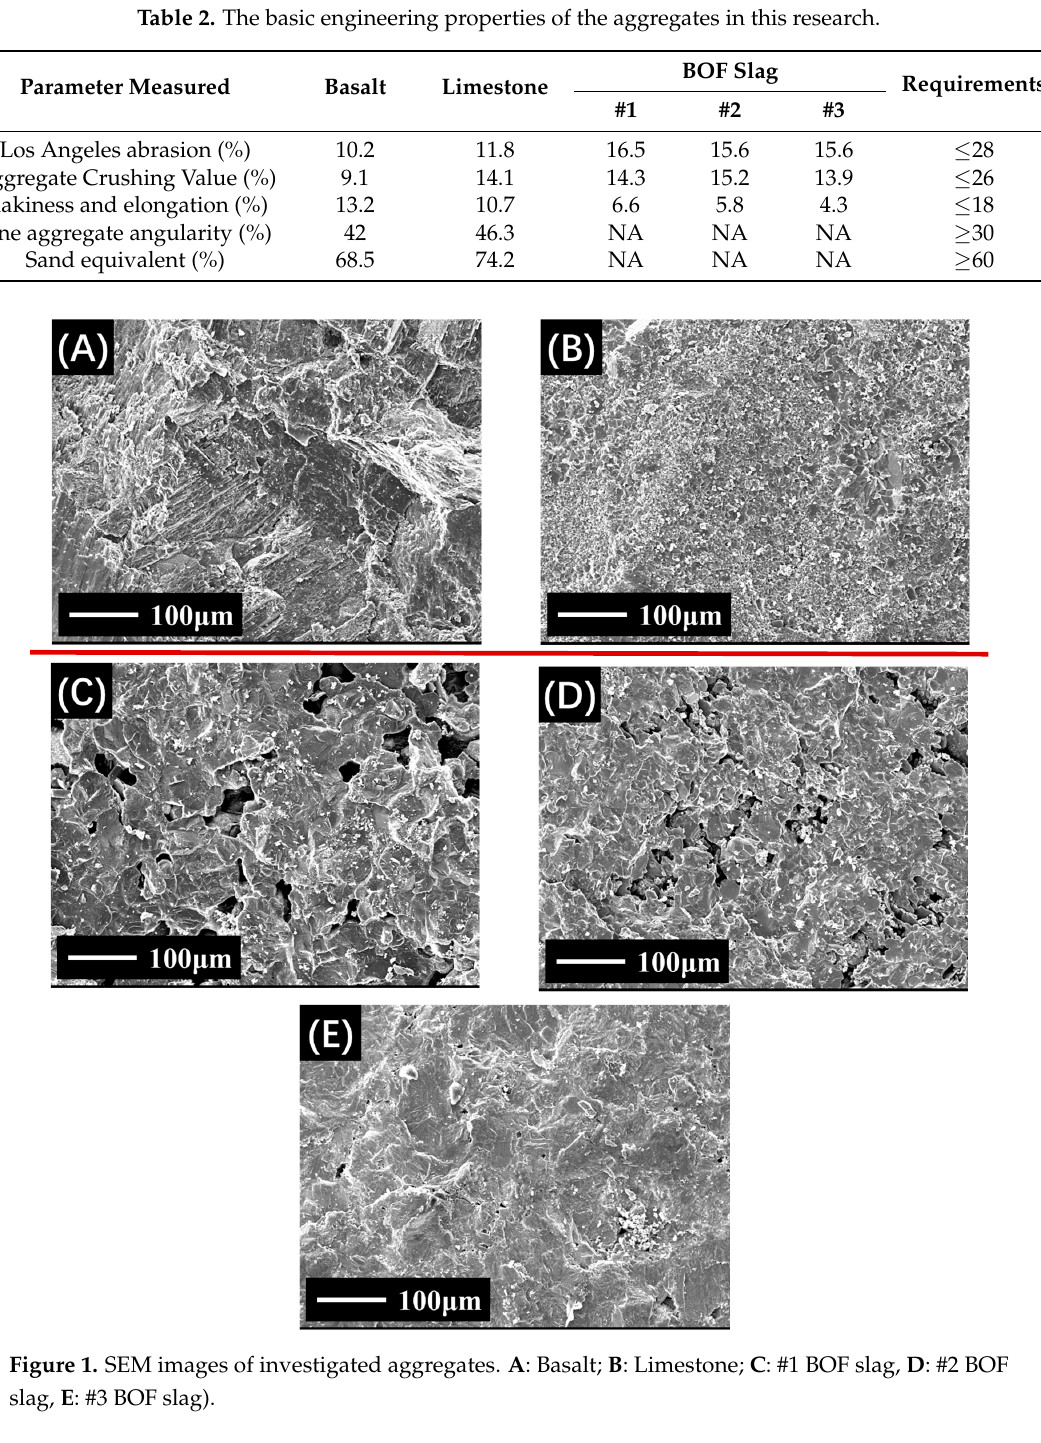
Table 2. The basic engineering properties of the aggregates in this research.